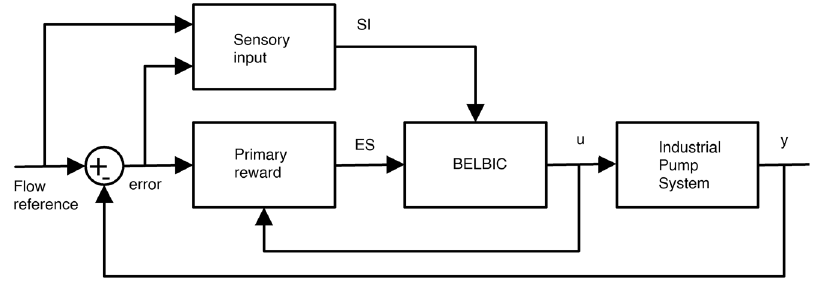
Figure 8. Block diagram of SI and ES inputs—created using PowerPoint software version Microsoft